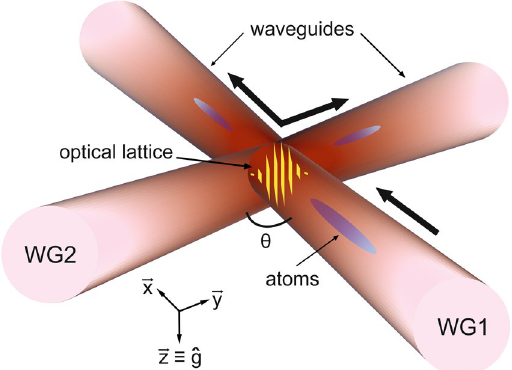
Figure 1. Schematics of the distributed quasi-Bragg reflector in crossing atomic waveguides. The two waveguides are realized by the same off-resonant laser and produce an inhomogeneous optical lattice in the crossing region where they interfere. We use this configuration as a controllable beam splitter to divide a BEC, which initially propagates along one linear waveguide (WG1), into two different fragments moving along each of the two waveguides (WG1 and WG2) which cross with a variable angle θ